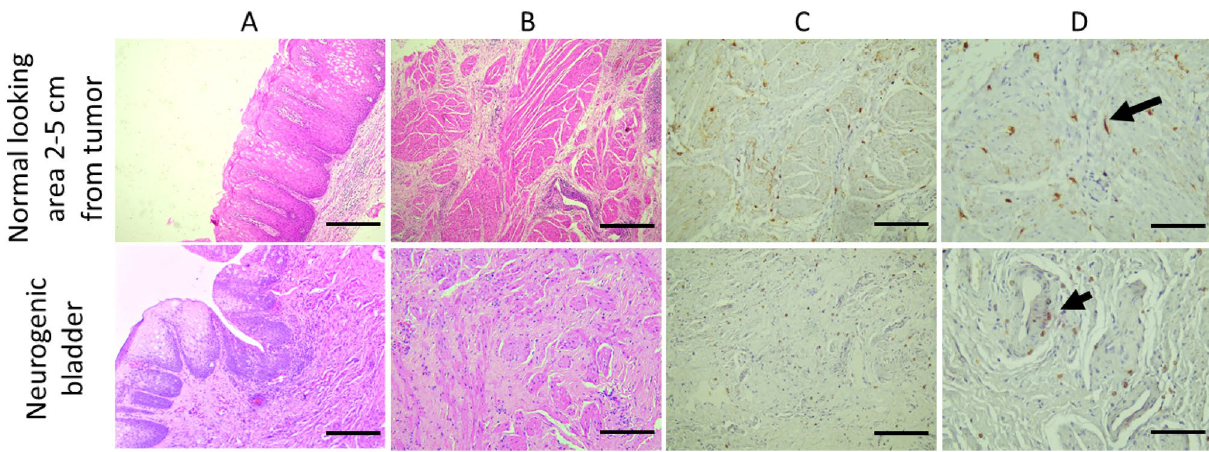
Figure 1. Light microscopy with H&E and cKit IHC findings in normal-appearing tissue of urinary bladder with UBC: ( A , B ) showed no evidence of cancer in mucosa, submucosa and muscularis propria layers. ( C , D ) cKit IHC shows intense distribution of cKit + ve cells in the muscle layer (long arrow). Neurogenic bladder: ( A , B ) showing increased collagen within the muscle layer. ( C , D ) cKit IHC shows of cKit + ve cells mainly